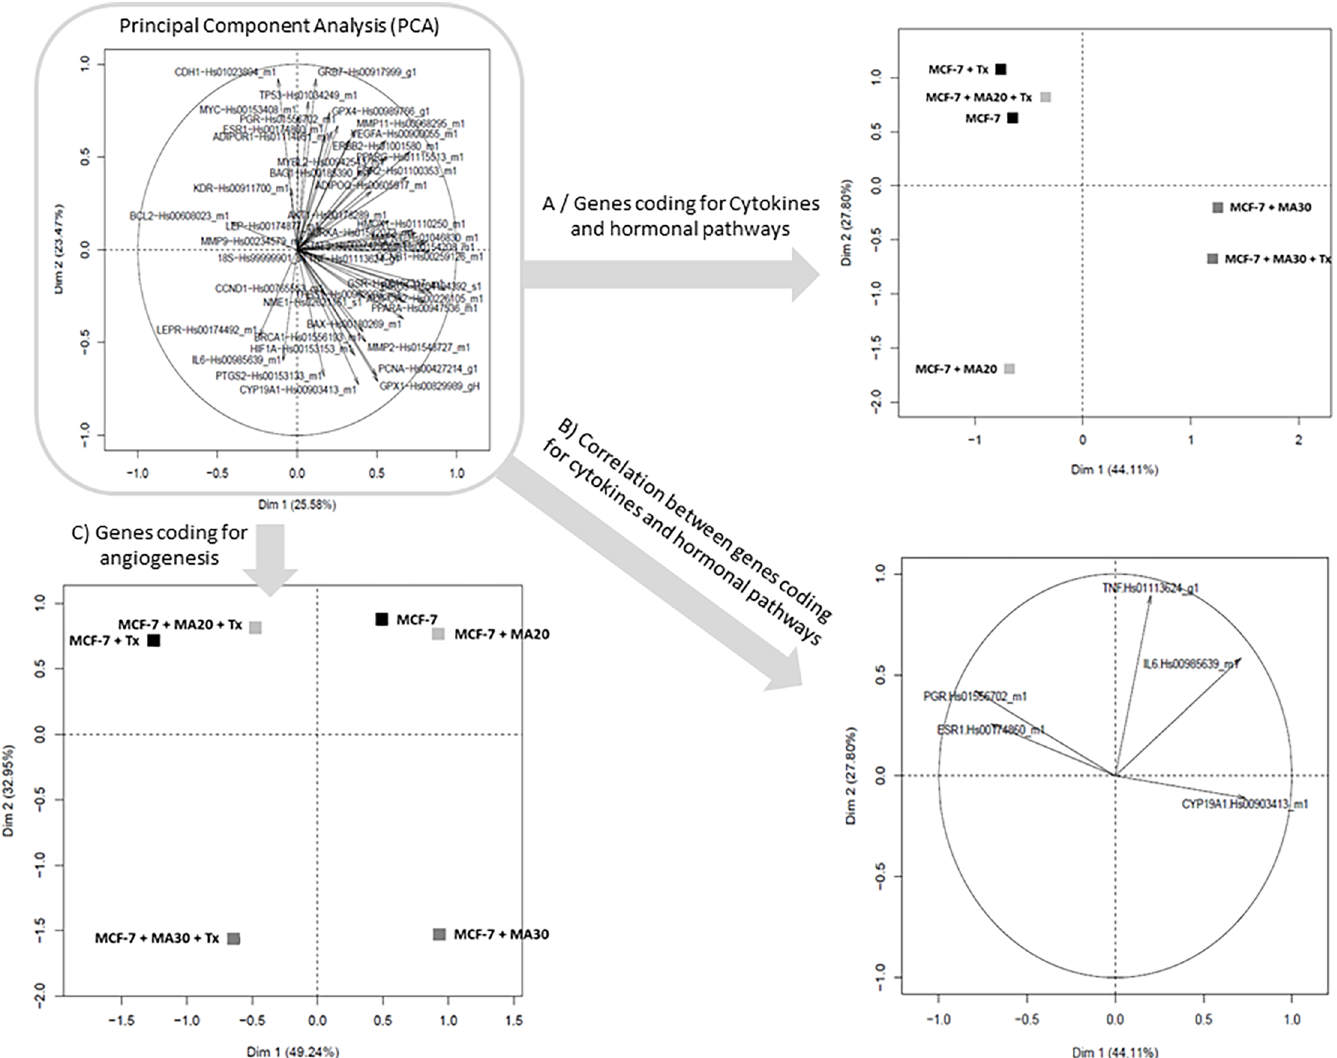
Fig 3. Principal component analysis (PCA) to explore the relationships among genes on 3D adipose skin equivalent model. The expression of genes in MCF-7 mammary cell line co-cultured or not with mature adipocytes from women with a normal weight (MA20) or obese women (MA30) with or without tamoxifen treatment were analyzed by PCA. A first global PCA was carried out (A) followed by a second one taking into account the biological function of the different studied genes (B, C, D,